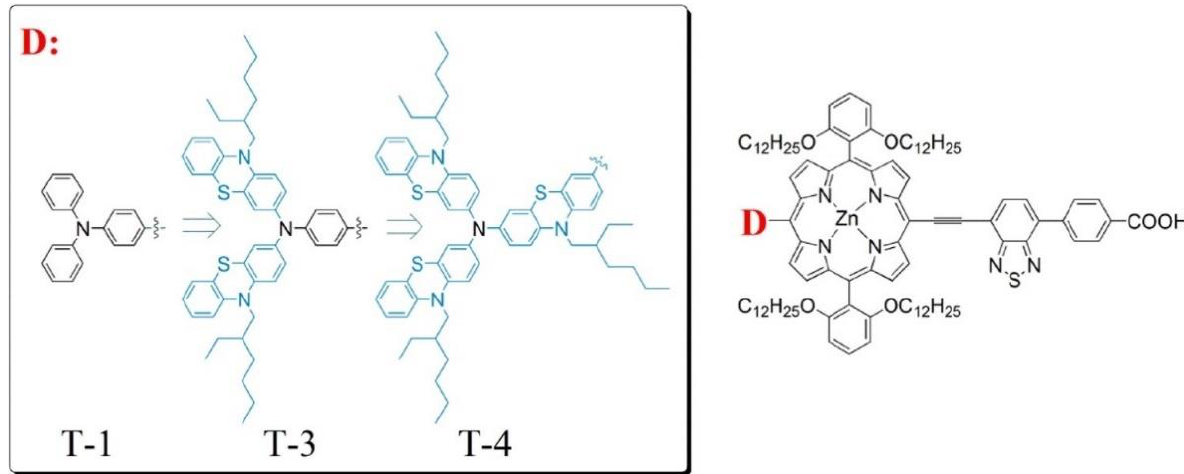
Figure 23. Molecular structures of porphyrin dyes showing increasingly bulky groups at the donor substituent. Reproduced from reference [99] with permission from the American Chemical Society, copyright 2021.